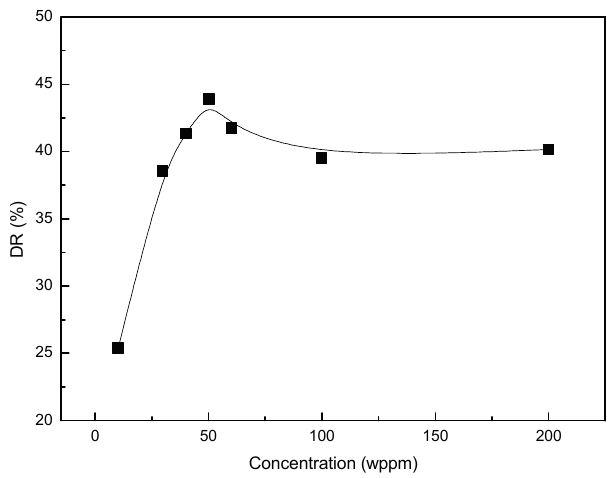
Figure 3. Drag reduction (DR) efficiency as faction of poly(ethylene oxide) (PEO), and polyacrylamide (PAAM) concentration (Reprinted from [54]).